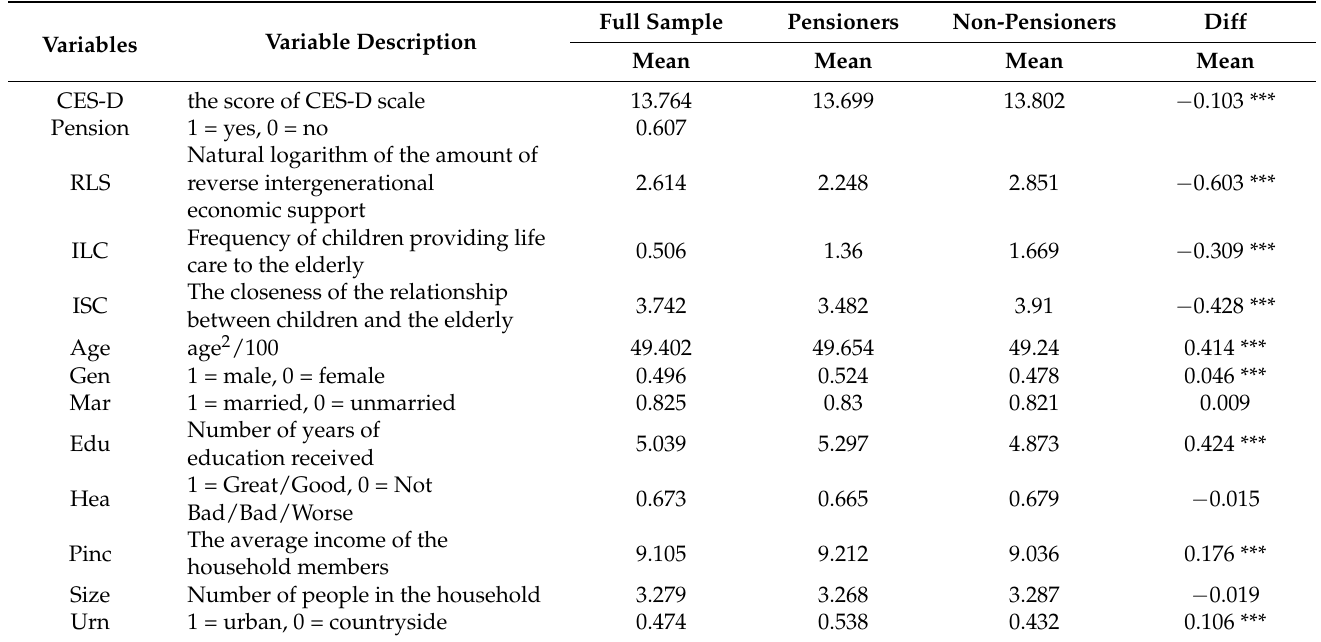
Table 1. Descriptive